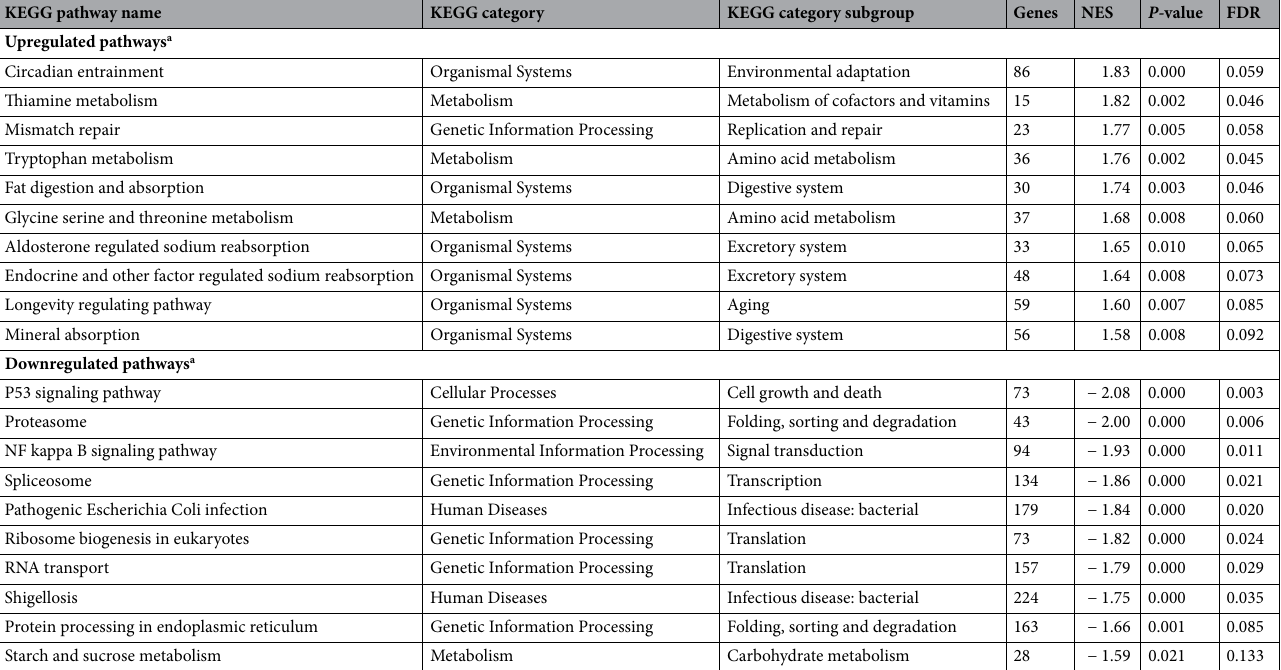
Table 5. Top 10 most enriched (based on NES) up- and downregulated pathways related to the intestine in induced pluripotent stem cell derived intestinal epithelial cell layers exposed to 10 mM propionate compared with the control. a References indicating their role or relationship to the intestine for the selected pathways are given in the supplementary files; Table